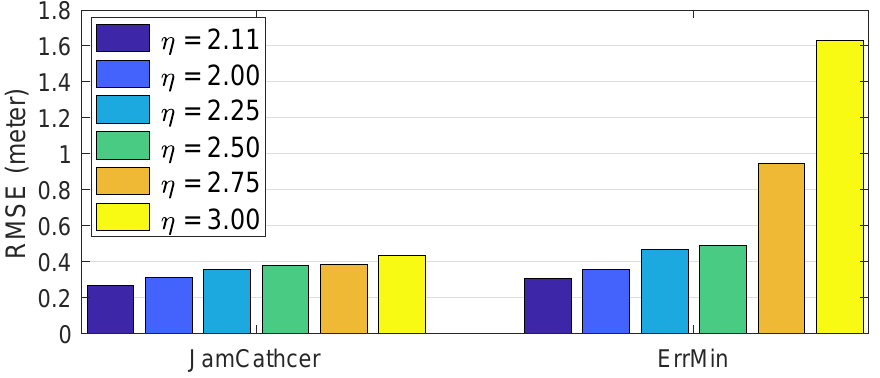
Figure 8. Impact of estimation error in η on the performance of JamCatcher and